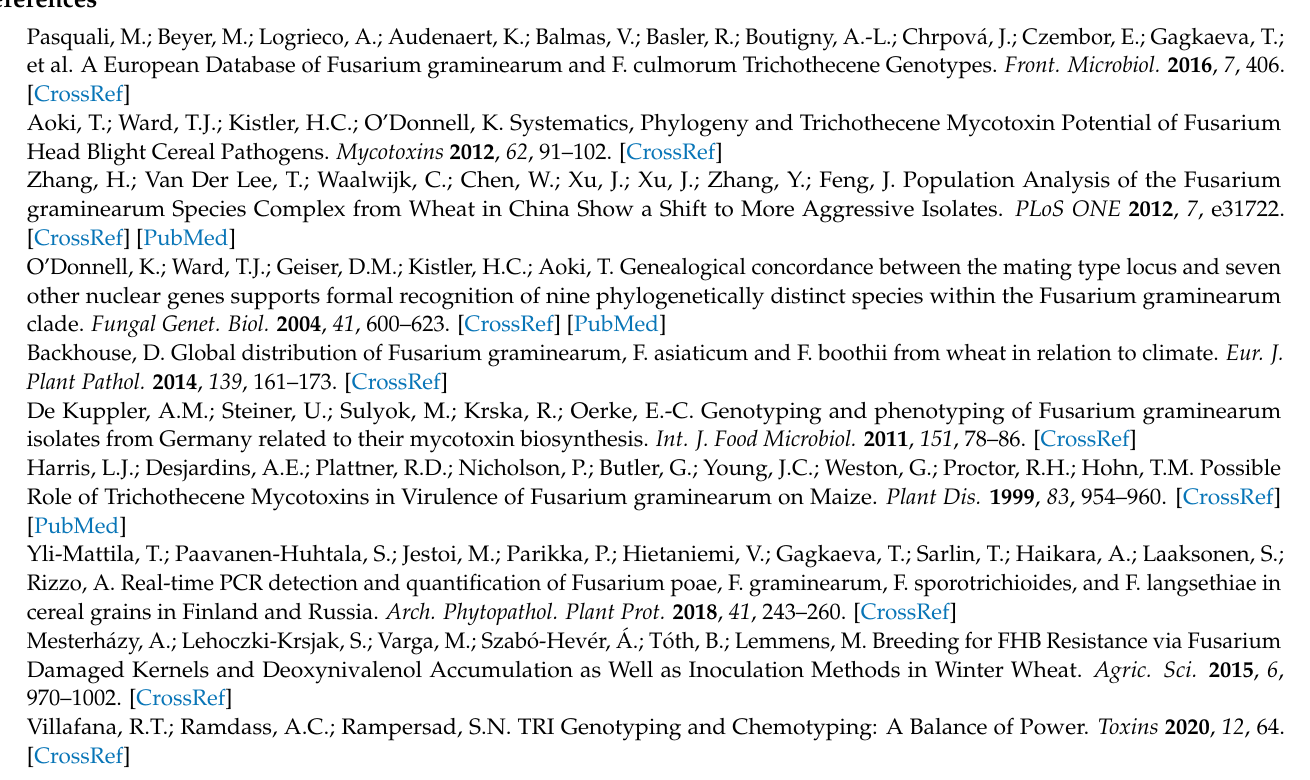
and F. poae in a three-year period in 32 locations in Serbia. Table S2: Diversity of trichothecene genotypes of FGSC from winter wheat in Serbia. Table S3: Climatic conditions in a three-year period (2017–2019) at the time of the anthesis of the winter wheat in agroecological conditions in Serbia. Table S4: Regression analysis of the most influencing factors on grain infection with FGSC in the period 2017–2019. Table S5: Relative frequencies of Tri7 alleles in DON producers originating from Serbia. Table S6: Relative frequencies of Tri7 alleles in F. graminearum s. stricto, F. graminearum s. lato, and nonidentified (FGSC). Table S7: Amount of variance explained by each principal component in the MCA